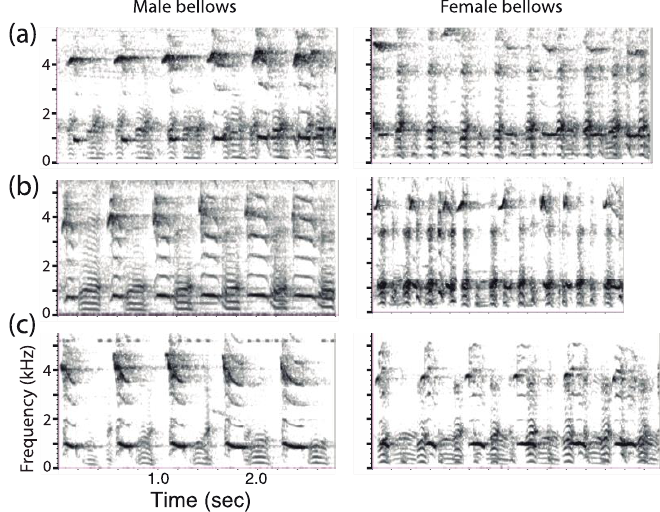
Figure 7. Exemplars of bellows emitted by ( a ) P. discolor , ( b ) P. aureipalatii , and ( c ) P. toppini . Left: putative male bellows. Right: putative female bellows. Note the joint emission of pant calls by the partner.